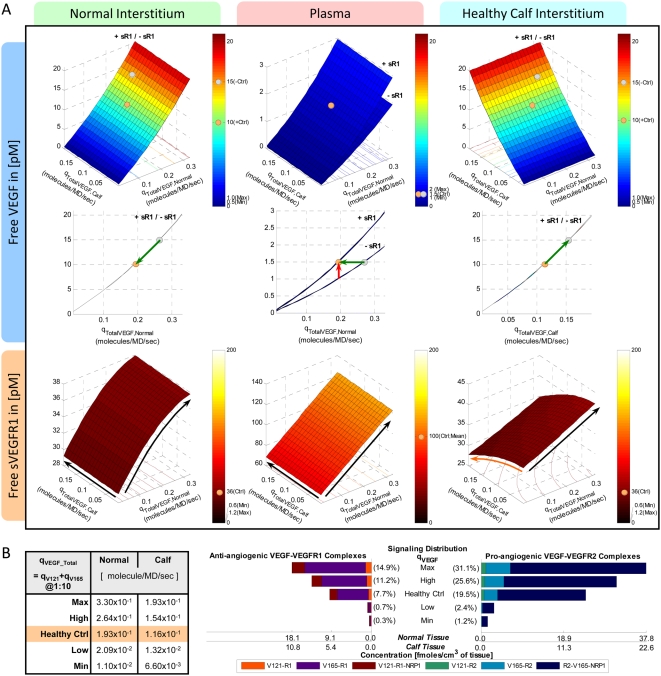
Targeting Control VEGF-Secretion Rates (qTotalVEGF) for Basal Profile of Healthy Subject.A. Steady-state sensitivity of plasma and interstitial concentrations of free VEGF (top and middle rows) and free sVEGFR1 (bottom row) to qTotalVEGF from normal tissue (y-axis) and calf (x-axis. VEGF isoforms were secreted at a ratio of VEGF121∶VEGF165 = 1∶10. Top/middle row: In absence of sVEGFR1 (qsR1 = 0; labelled ‘-sR1’), plasma free VEGF reached the targeted 1.5 pM at the control VEGF-secretion rates of qV,-Ctrl = (qTotalVEGF,Normal, qTotalVEGF,Calf) = (0.264,0.154) molecule/MD/s. The incorporation of sVEGFR1 expression (qsR1 = qsR1,Ctrl; labelled ‘+sR1’) raised plasma VEGF significantly (red arrow) but with negligible effects on interstitial VEGF. To keep plasma free VEGF at the targeted 1.5 pM, the control VEGF-secretion rates were redefined (green arrow) to be qV,+Ctrl = (qTotalVEGF,Normal, qTotalVEGF,Calf) = (0.1925,0.1155) molecule/MD/s. Grey and beige spheres mark the interstitial and plasma VEGF levels reached at qV,-Ctrl and qV,+Ctrl respectively. Bottom row: Despite sVEGFR1's role as a VEGF sink, free sVEGFR1 only changed inversely relative to free VEGF changes in the calf interstitum in the direction of increasing qTotalVEGF,Calf. Orange/black arrows indicate inverse/direct relation between sVEGFR1 concentrations and VEGF-secretion rates. B. Density of VEGF-VEGFR complexes changed in proportion to interstitial free VEGF levels with increasing qTotalVEGF. Bracketed percentages are VEGF-bound fractional occupancies of total VEGFR, averaged (range<0.3%) between normal and calf compartments. In figure: ‘+’ = control; ‘max’ and ‘min’ bound targeted ranges; ‘MD’ = myonuclear domain; ‘V121’ = VEGF121; ‘V165’ = VEGF165; ‘R1’ = VEGFR1; ‘sR1’ = sVEGFR1; ‘R2’ = VEGFR2.